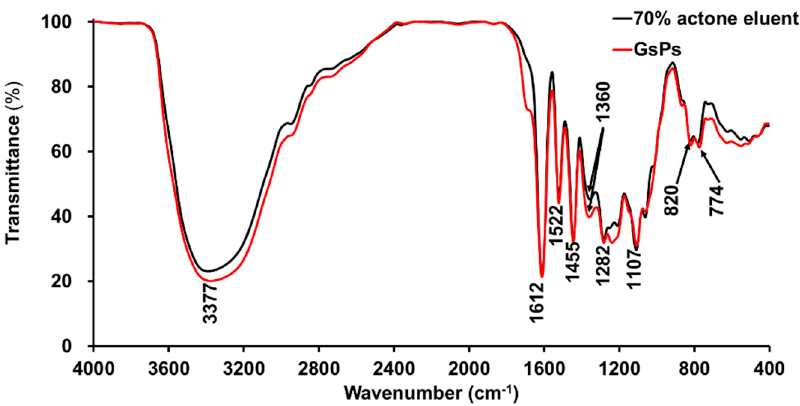
Figure 2. The FT-IR spectrum of the 70% acetone eluent of the rhizome of F. dibotrys and